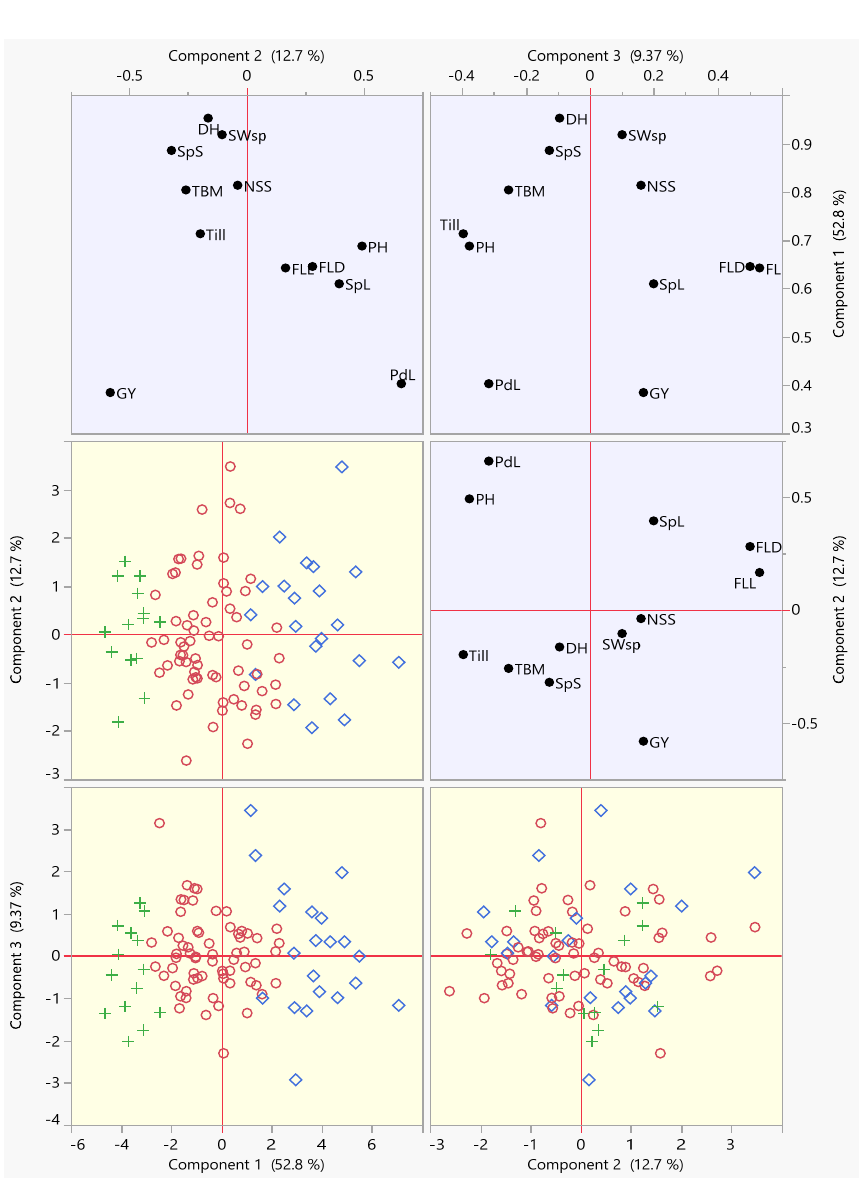
Figure 4. Squared cosines associated with the principal components for twelve studied traits of 101 parental wheat genotypes and RILs.